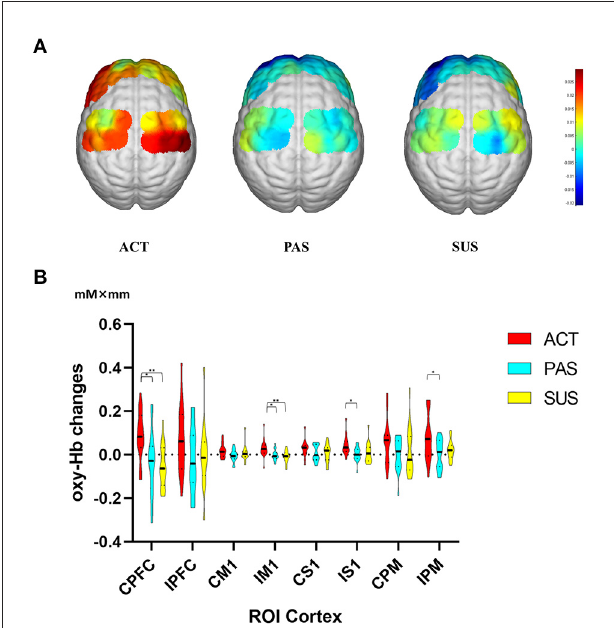
FIGURE4 (A) Activation maps of the mean oxy-Hb changes under three different conditions. (B) Average changes in oxy-Hb concentration of ROIs for three conditions. Comparisons of execution-related oxy-Hb changes of ROIs for ACT, PAS, and SUS. C, contralesional; I, ipsilesional; oxy-Hb, oxy-hemoglobin; ROIs, regions of interest; PFC, prefrontal cortex; M1, primary motor cortex; S1, primary somatosensory cortex PM, premotor area, and supplementary motor cortex. * p < 0.05, ** p < 0.01. Data are expressed as the mean with standard error